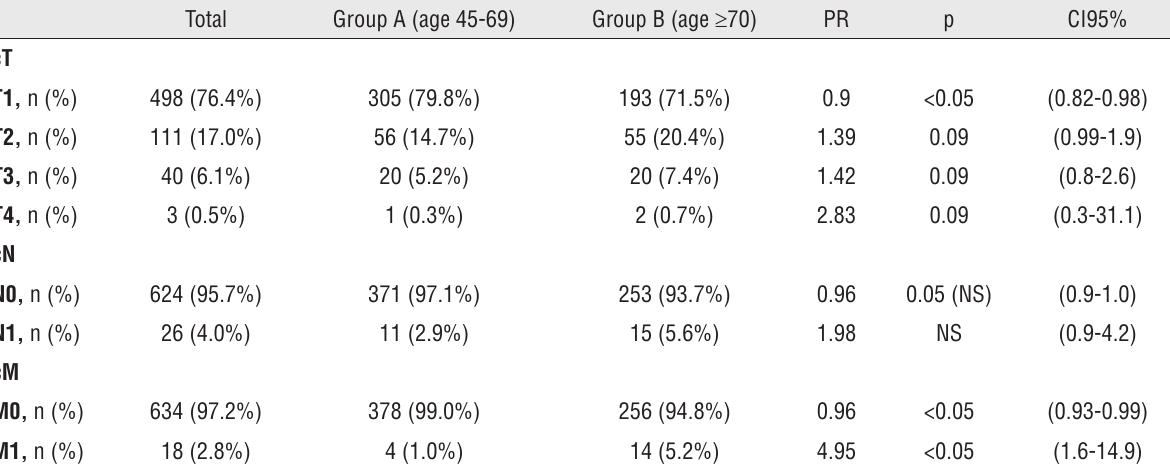
Table 3 - TNM Staging.